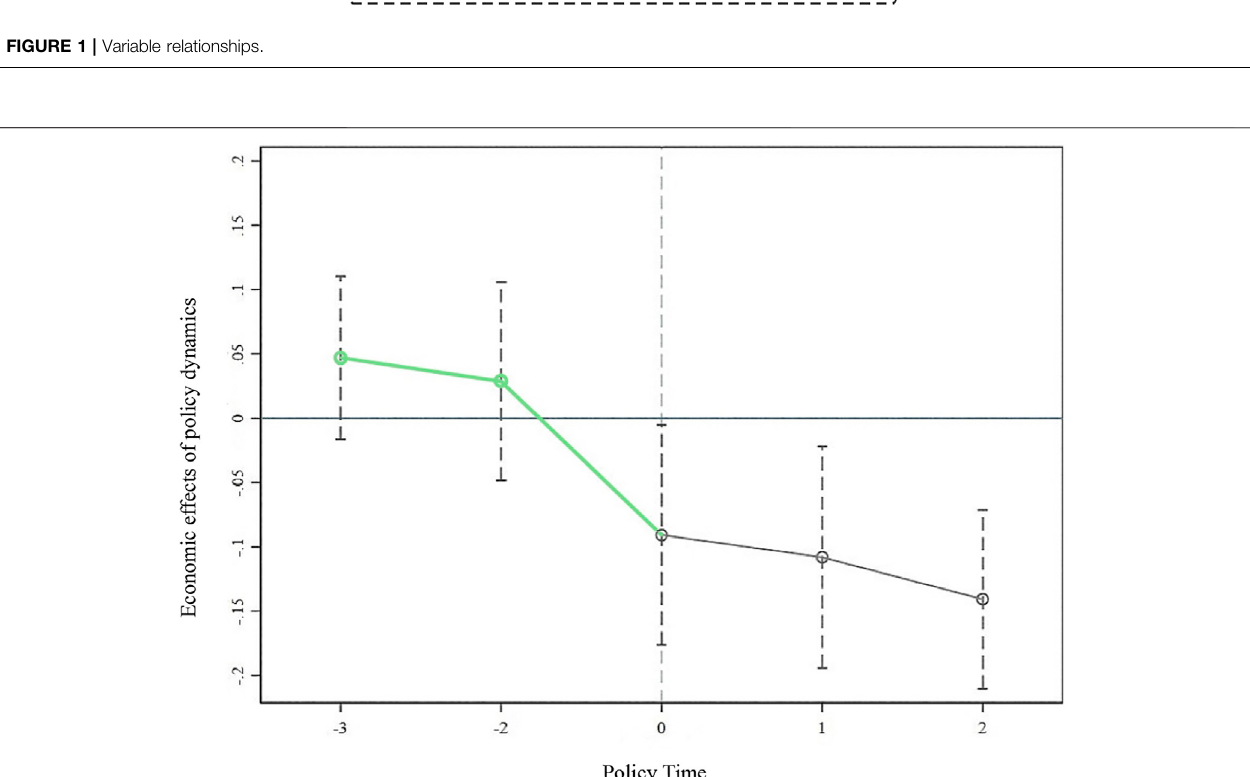
FIGURE 2 | Parallel trend test chart.